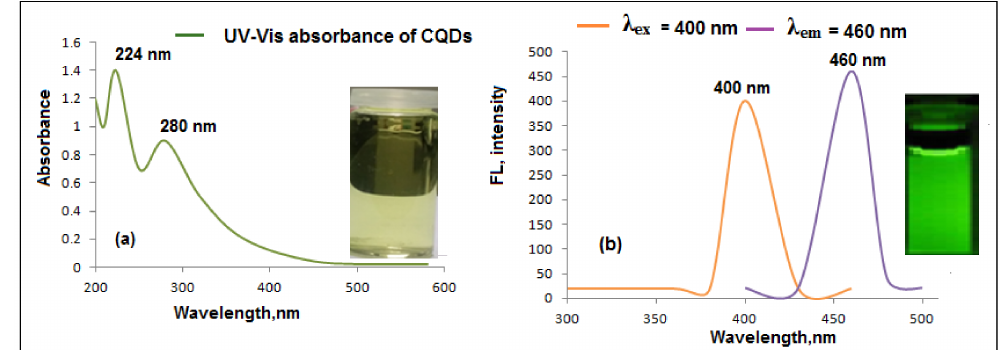
Figure 2. Spectroscopic detection of CQDs. ( a ) UV-Vis spectrophotometric absorption spectrum of CQDs and ( b ) spectrofluorimetric detection of CQDs at λ ex = 400 and λ em = 460 nm.